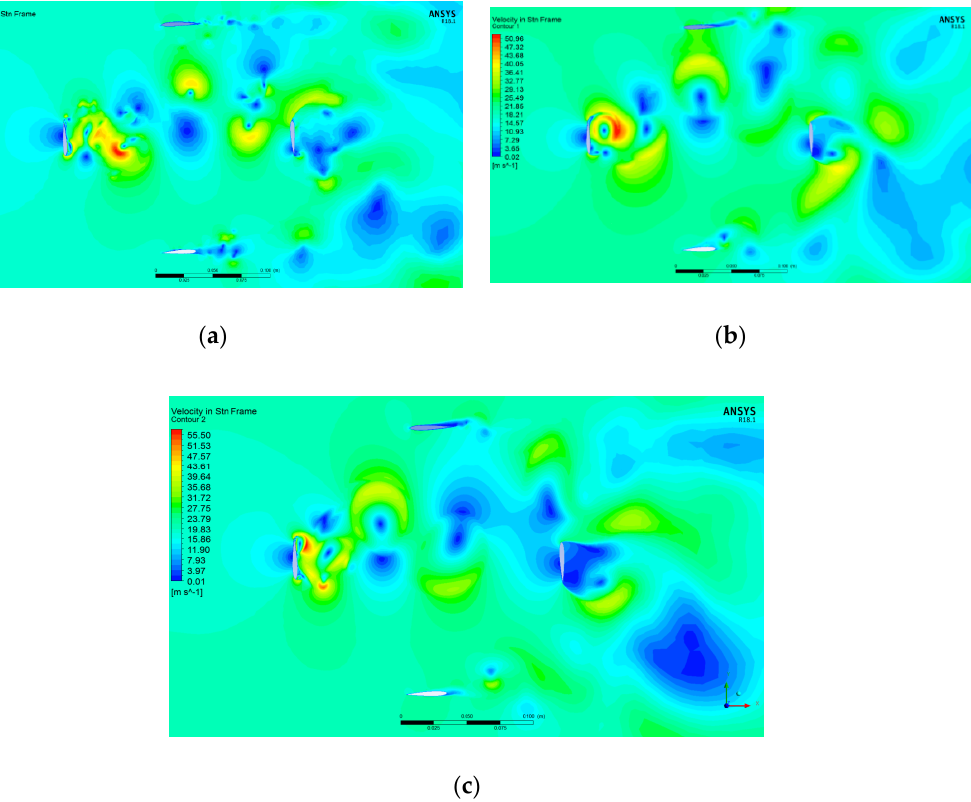
Figure 8. Contours of velocity magnitude for DDES ( a ), RANS Transition ( b ) and RANS SST k-ω ( c ) at 0° azimuthal position at λ max = 0.29.